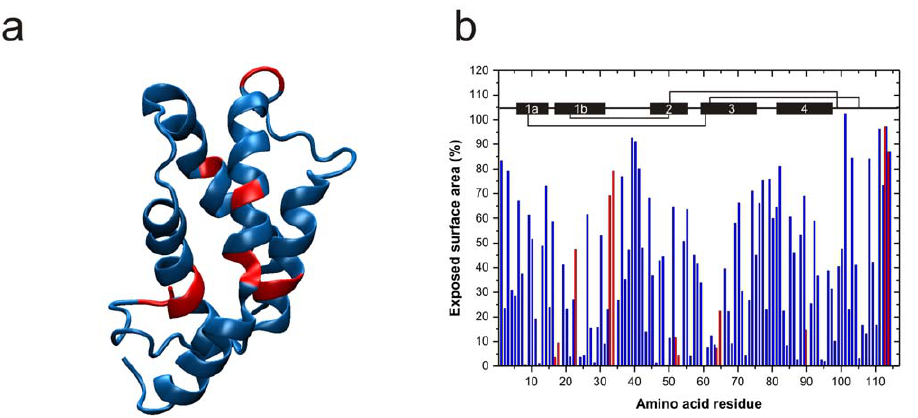
Figure 2. Theroretical pepsin cleavage sites and solvent exposed residues. a) Theoretical pepsin cleavage sites (red) mapped on the tertiary structure of Ber e 1. b) Exposed surface area of the N and H N atoms in the backbone of Ber e 1. Residues able to undergo pepsin cleavage are highlighted in red. The secondary structure elements, as well as the cysteine linkage are indicated in the top of the figure. Most of the theoretical pepsin cleavage sites are buried within the a -helices. The only surface exposed pepsin cleavage sites are located in the non-native loop and the C- terminal, and cleavage at these positions would not disrupt the integrity of the structure.